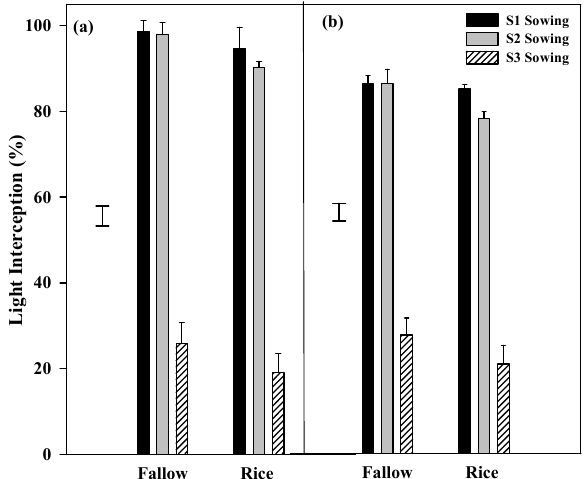
Figure 4. Light interception of ( a ) field pea and ( b ) faba bean crops measured at crop flowering in post ‐ rice and post ‐ fallow conditions, at three sowing dates. Error bars at the tops of columns represent standard deviations of means ( n = 12), and error bars at the left of the filled black bars represent LSD values at the 0.05 level of